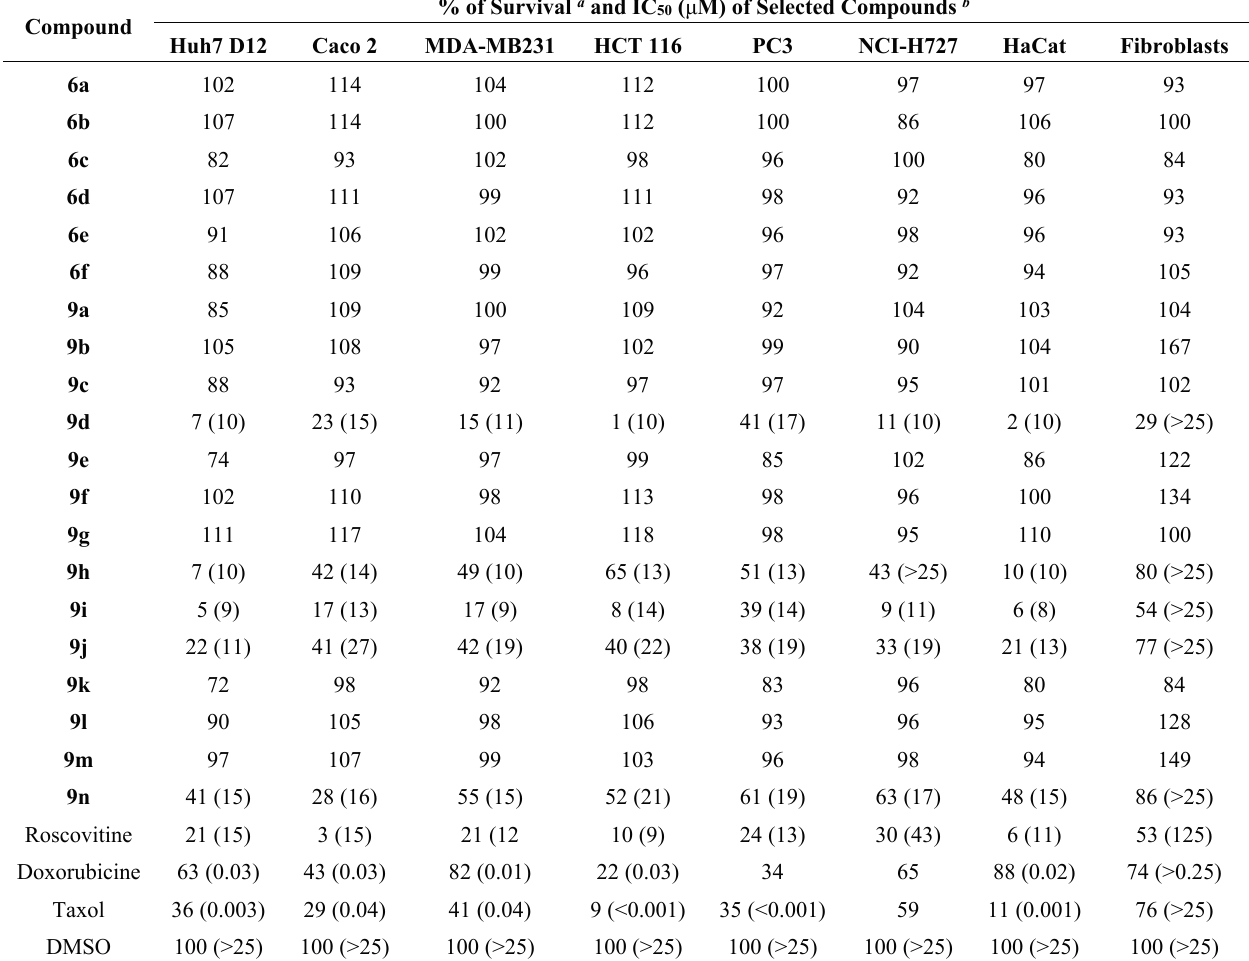
Table 2. Antiproliferative activity of compounds 6 ( a – e ) and 9 ( a – n ) on six representative tumor cell lines.